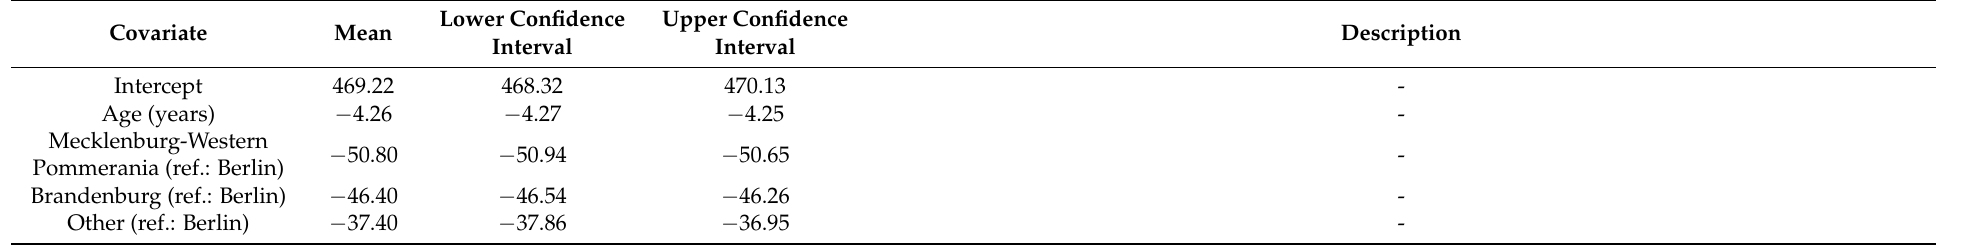
Table 4. Association between covariates and total annual costs (2014) for dental